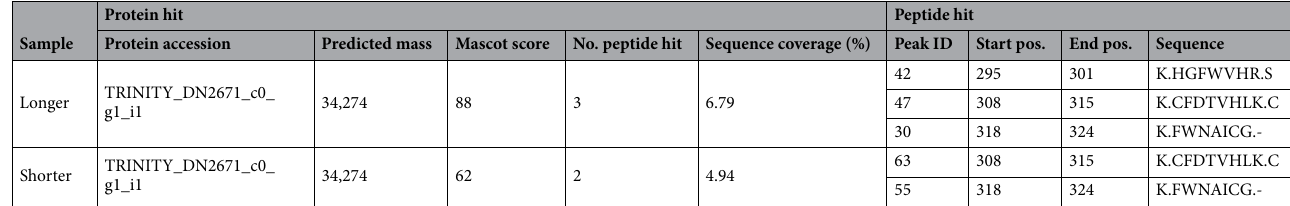
Table 1. Results of protein identification using LC–MS/MS.